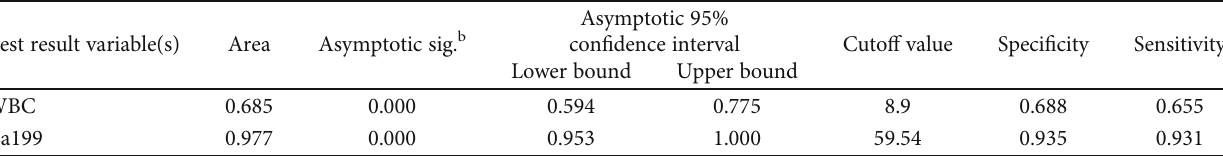
Table 4: Area under the